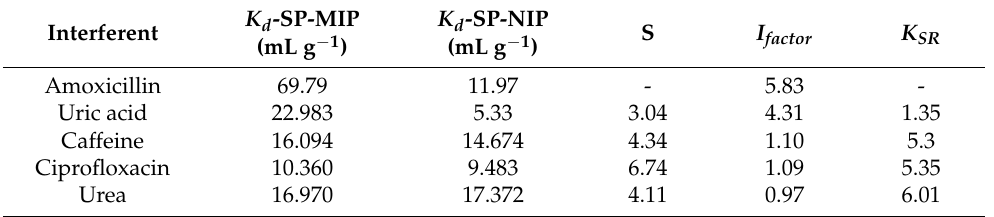
Figure 10. Profiles of the results obtained from the selectivity analysis conducted in this study using optimal conditions. Table 5. Selectivity parameters for amoxicillin removal (SP-MIP and SP-NIP) using optimal